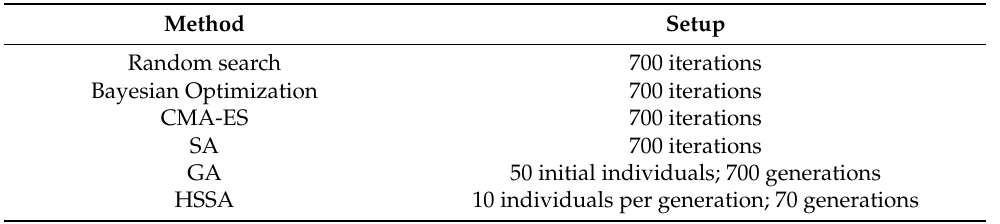
Table 7. Settings of each algorithm in the experiment on Five Flowers.